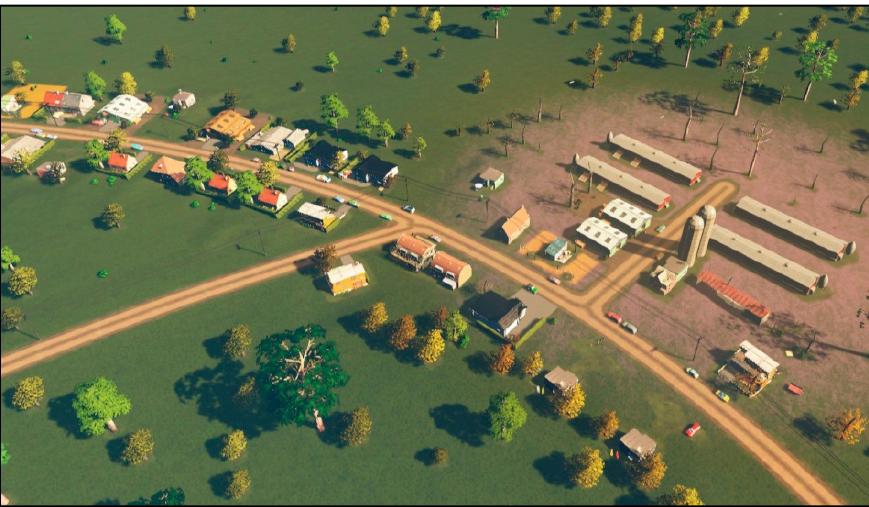
Figure 9. Environmental degradation around the farm.